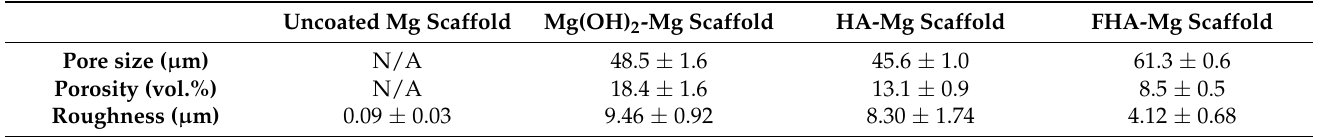
Table 3. Porosity and surface roughness of the uncoated and hydrothermally coated Mg-based